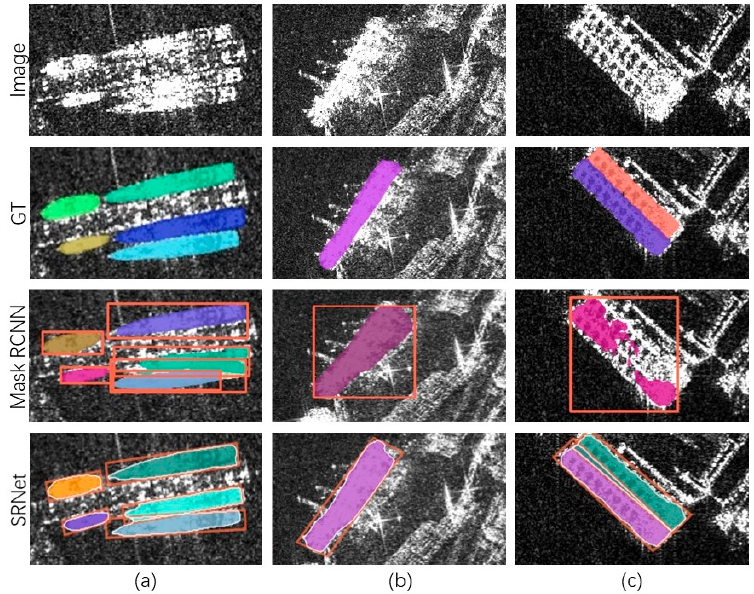
Figure 1. Visual comparison between the instance masks from the HB-Box-based Mask RCNN and from our RB-Box-based SRNet. ( a ) The scene of the densely packed ships. ( b ) The scene of the ship berthing in a dock. ( c ) The scene of parallel ships.